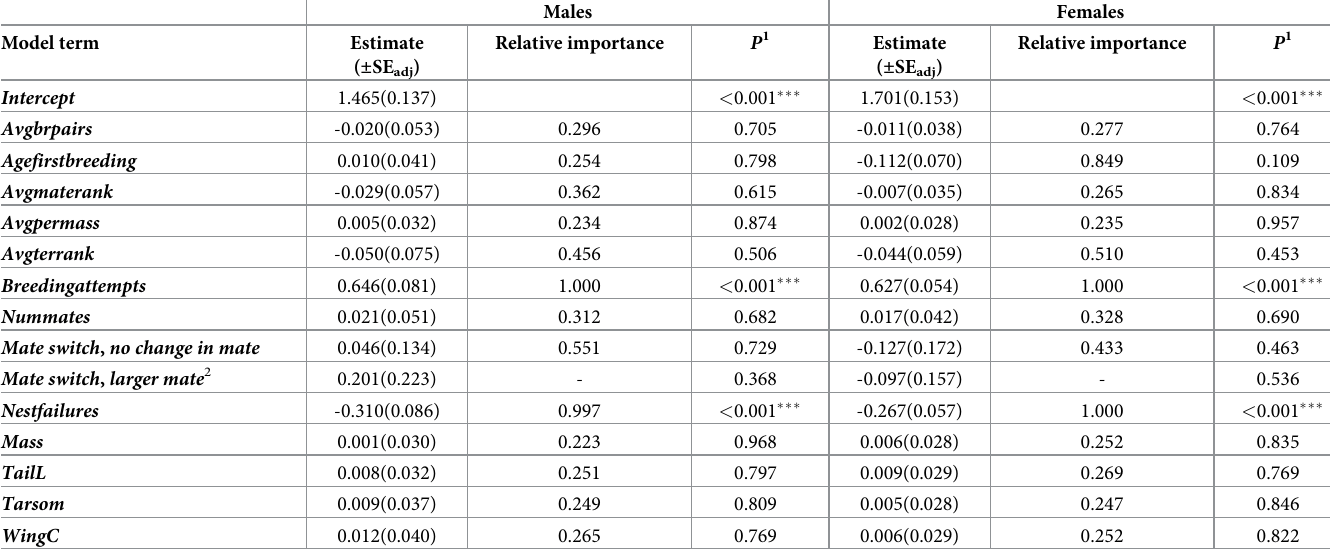
), relative importance, and p -values for the model adj